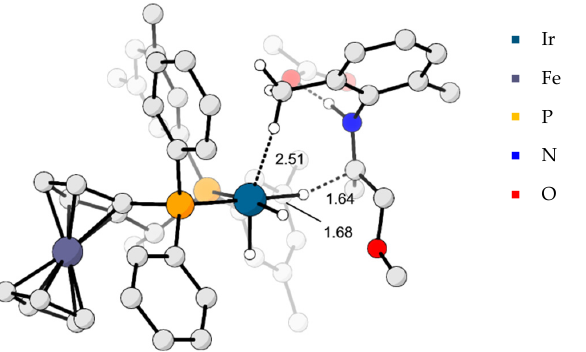
Figure 9. Alternative pro-( S ) transition state TS2 ( S ’) with hydride transfer to the higher energy ( Z )-iminium-acetate adduct with relevant atomic distances reported in Å. Most C-H hydrogens were omitted for clarity.